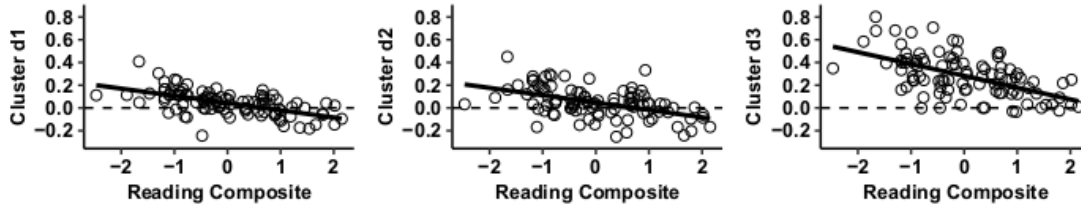
Figure 5. Whole-brain functional connectivity correlations with reading composite score for MVPA Cluster c.